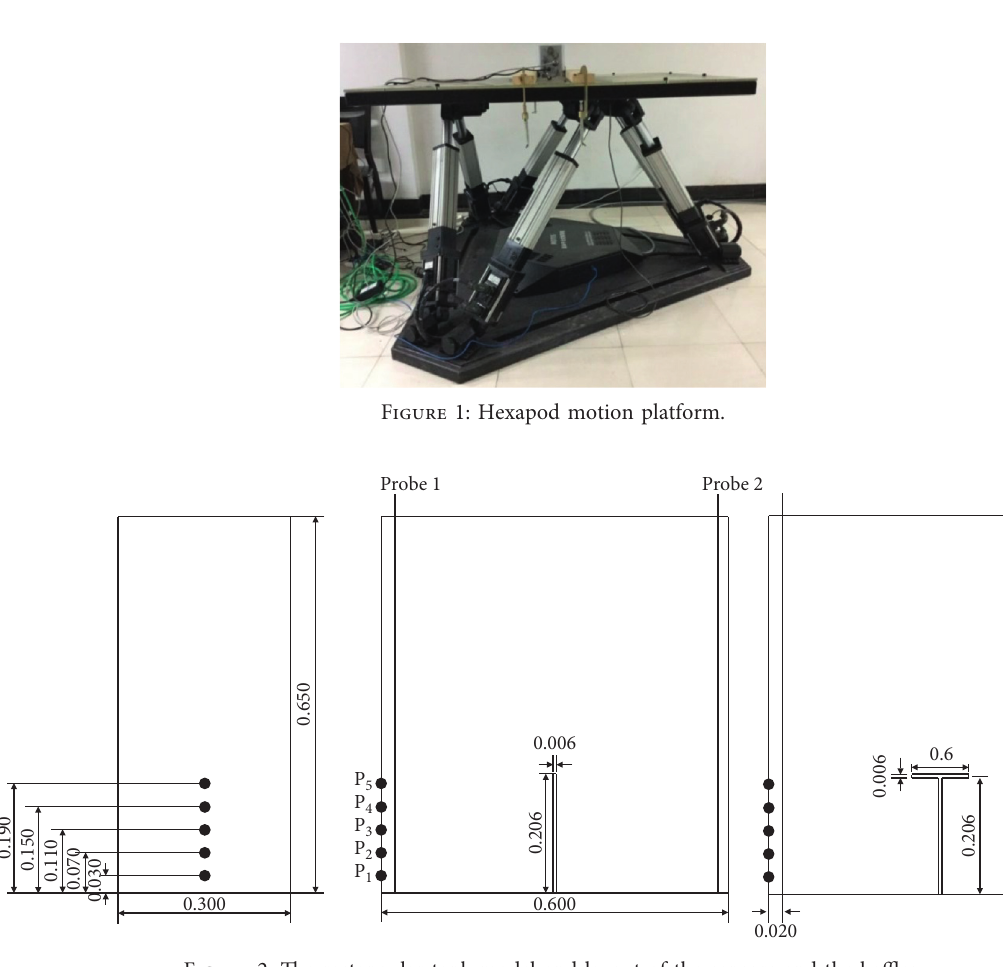
Figure 2: The rectangular tank model and layout of the sensors and the baffles.